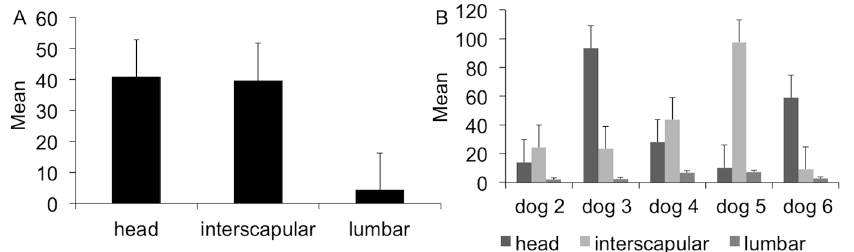
Figure 3. Distribution of microfilariae of Onchocercalupi . Overall (A) and individual (B) mean number of microfilariae of Onchocerca lupi found in each body site of dogs